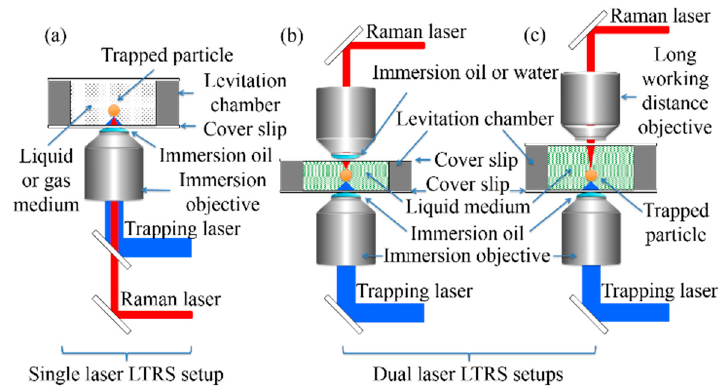
Figure 1. Schematic illustrations of the two main microscope objective coupling configurations currently used in laser tweezers Raman spectroscopy systems. ( a ) Single inverted immersion objective configuration, ( b ) two immersion objectives and ( c ) an inverted immersion objective combined with a long-working-distance objective.